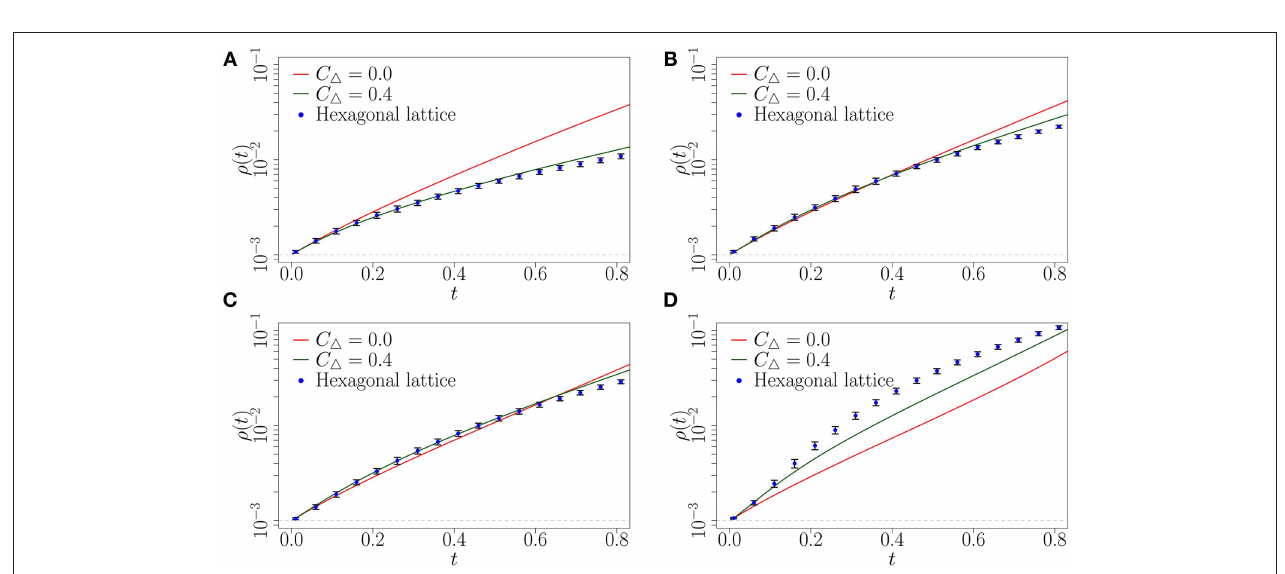
FIGURE 9 | Fraction ρ ( t ) of infected nodes on random network (solid red line), highly clustered clique-type network (solid green line) and hexagonal lattice (blue points). Solid lines represent the results from the CA method. Symbols represent the mean of 10 Monte Carlo realizations (the error bars indicate one standard deviation above and below the mean). (A) β